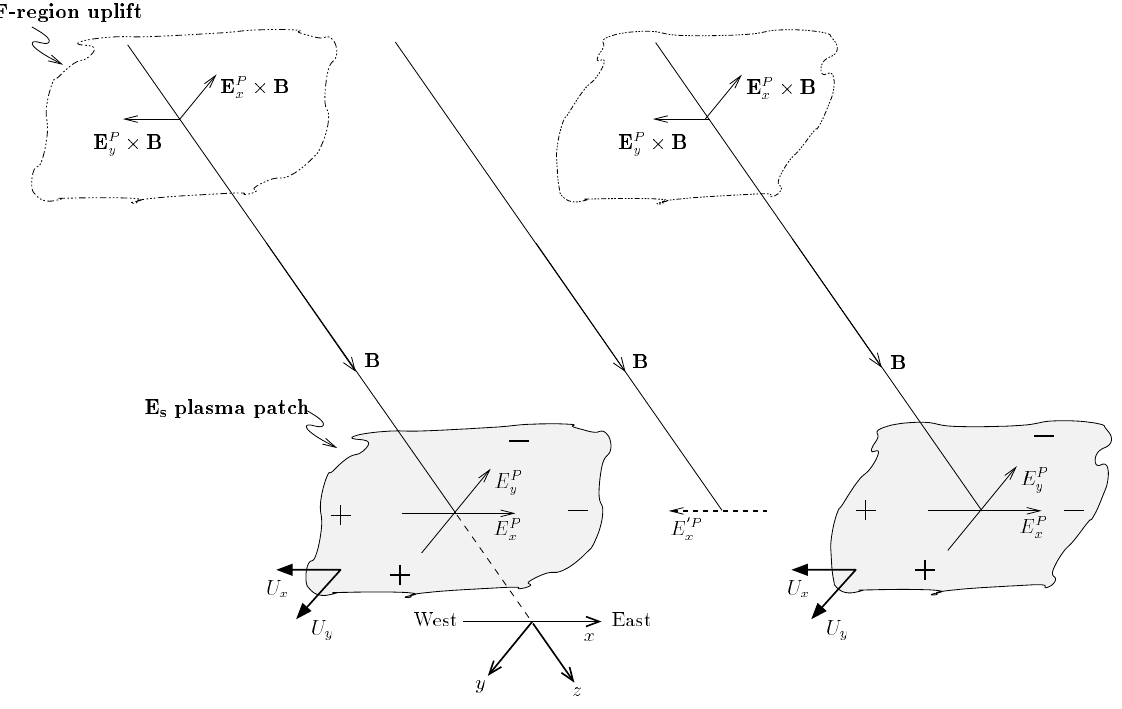
Fig. 1. Schematic illustrating the electrical coupling between sporadic- E patches and the F region which can lead to spread- F generation. Under the action of a west-south wind the sporadic- E patches become polarized and a polarization electric field builds up pointing into the north-east quadrant. This field maps to the F region bottomside where it causes E × B plasma uplifts and westward